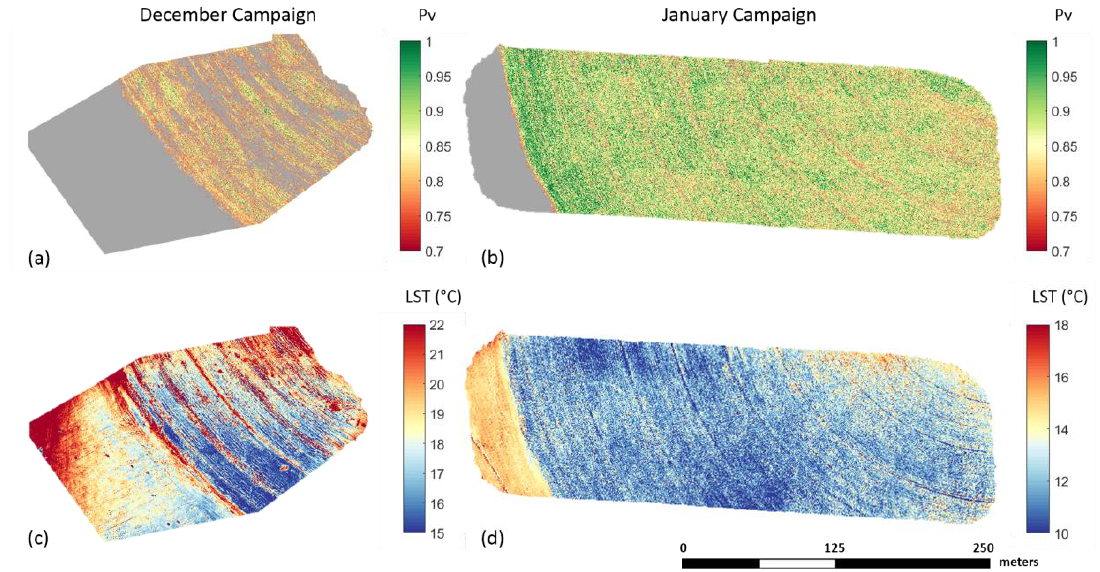
Figure 8. Maps of the proportion vegetation ( a , b ) estimated by using red–green–blue (RGB) camera and the range of diurnal LST ( c , d ) for the December campaign ( a , c ) and January Campaign ( b , d ). Grey areas are considered as desert or bare soil surfaces.